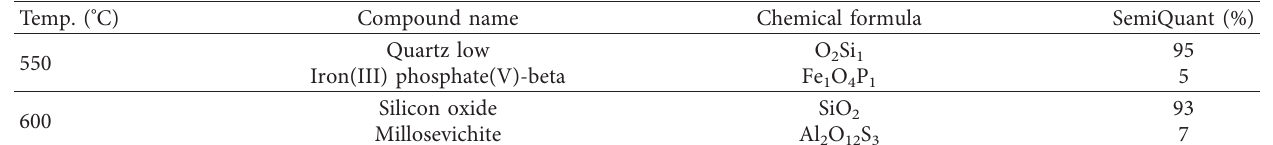
Table 8: XRD analysis of BD-2A ash.